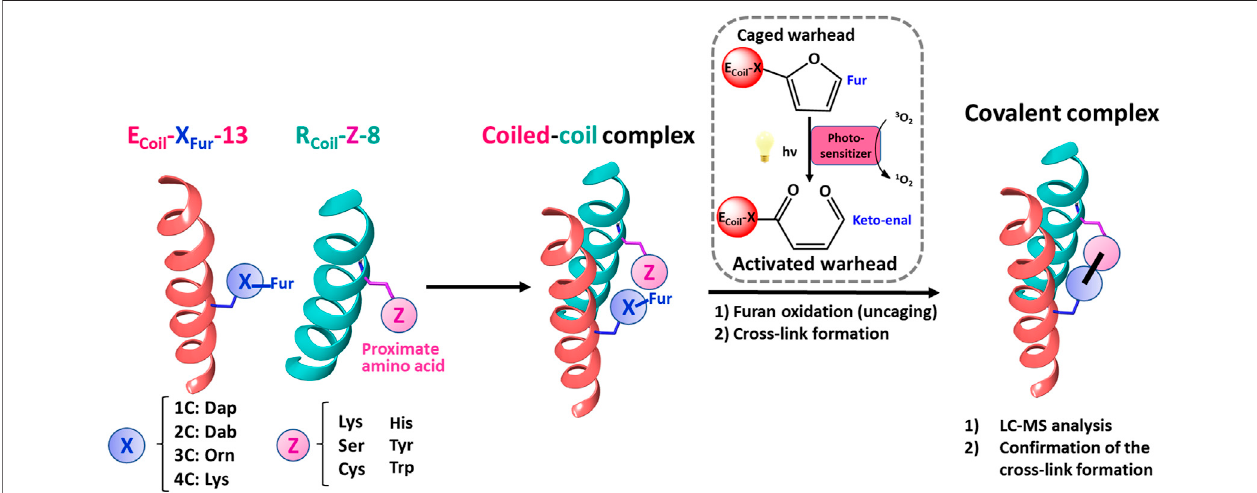
FIGURE7| SchematicrepresentationofthestrategyfollowedtoexplorefuranreactivityinanE3/R3coiled-coilpeptidedimer.Toscanthefuranwarheadreactivity towards additional cross-link partners, E Coil -X Fur -13 and R Coil -Z-8 were chemically synthesized. Dap, Dab, Orn, and Lys were introduced at position 13 on the E Coil as handles to introduce the Fur moiety. These four amino acids featuring varying lengths of methylene spacers were used to study the optimal distance between the furan moietyandthepeptidebackbonetoincreasetheef fi ciencyofcross-linkingbetweenthecoiled-coilmotifs.Ser,Cys,His,Tyr,andTrp,besidesLys,werechosenas potential new partners for the furan warhead and were placed at position 8 on the R Coil . All possible E/R coiled-coil partners were pre-incubated to allow coiled-coil complex formation, and then PSs (RB or Rhd B) were added and irradiated with light to afford covalently connected coiled-coil motifs upon furan activation.